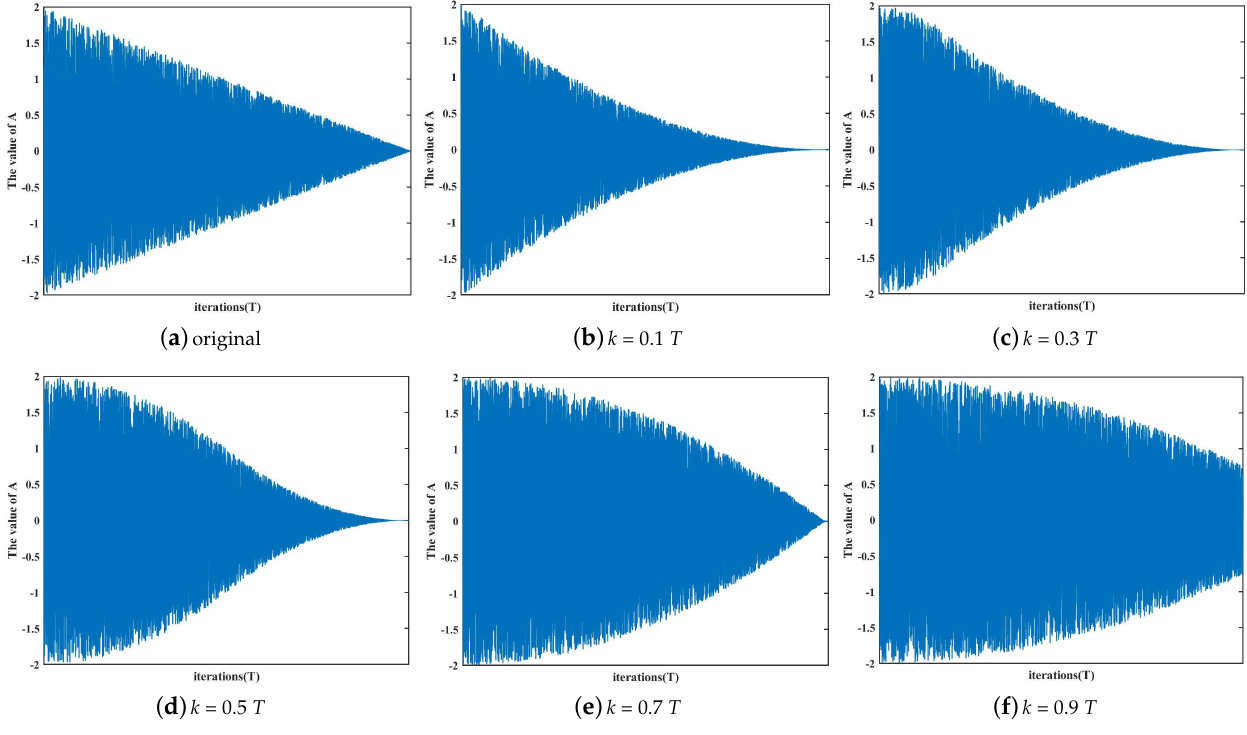
Figure 5. The impact on A when k takes different values, where T is the number of